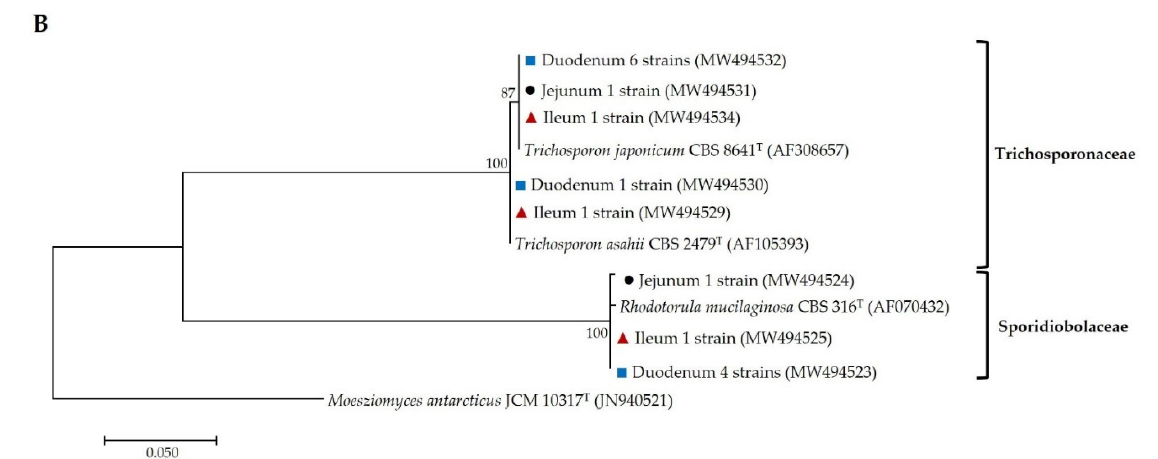
Figure 4 . Phylogenetic placement based on the sequence analysis of the D1/D2 domain of the LSU rRNA gene using the maximum-likelihood method (GTR model) of representative yeast species isolated from the small-intestinal epithelium of duodena ( ■ ), jejuna ( ● ) and ilea ( ▲ ) and their closely related type strain sequences received from the GenBank database. Numbers on branches demonstrate the bootstrap percentages (>50%), derived from 1000 replications. ( A ) Phylum Asco- mycota; scale bar, 0.1 substitutions per nucleotide position; Schizosaccharomyces pombe NRRL Y-12796 T (JQ689077) was used as the outgroup; ( B ) phylum basidiomycota; scale bar, 0.05 substitutions per nucleotide position; Moesziomyces antarcticus JCM 10317 T (JN940521) was used as the outgroup.